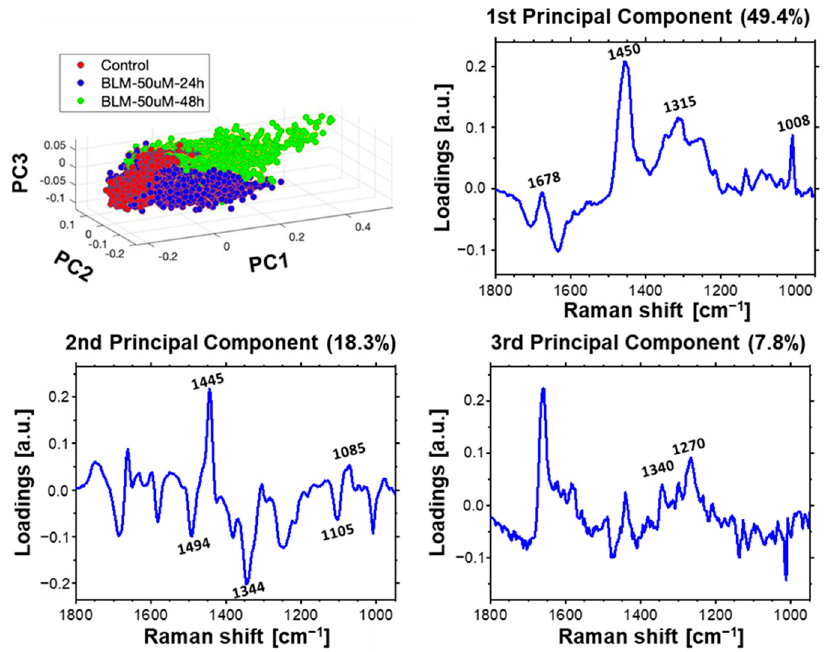
Figure 8. Time-dependent effect of BLM incubation. Results of PCA for Raman spectra acquired from nuclei of control cells and cells treated with 50 µM of BLM for 24 and 48 h. Loading plots of three first principal components are presented.